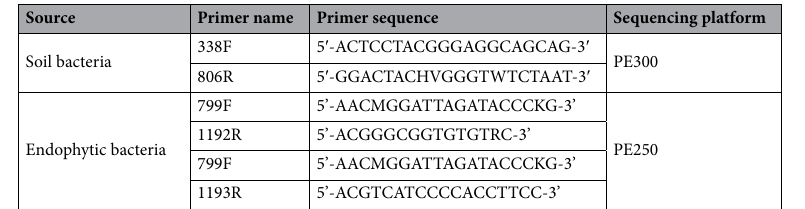
Table 1. The name of sequence type and primer